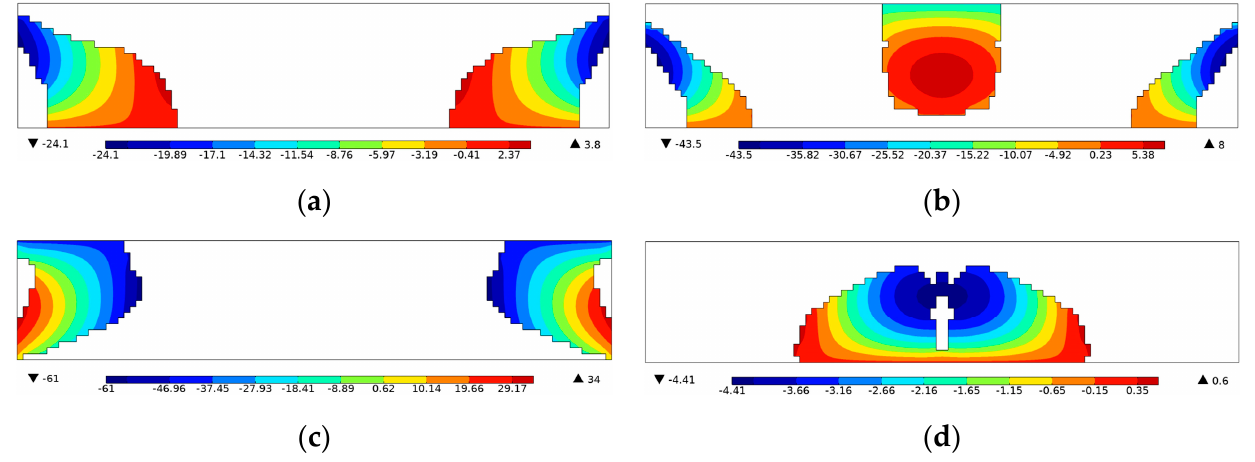
Figure 9. Voltage distribution of the open ‐ circuit voltage enhanced designs in Figure 8. ( a ) Voltage contour of Figure 8a, f = 4 kHz; ( b ) Voltage contour of Figure 8b, f = 6 kHz; ( c ) Voltage contour of Figure 8c, f = 10 kHz; ( d ) Voltage contour of Figure 8d, f = 16 kHz.